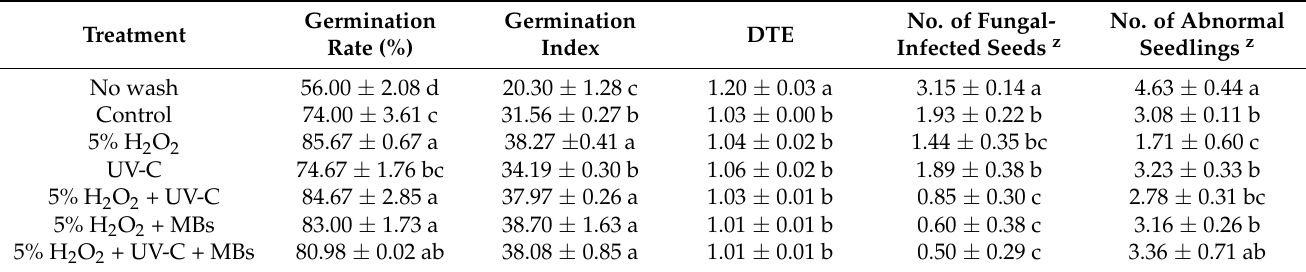
Table 2. Effects of seed decontamination treatments on percentage germination, germination index, days to emergence (DTE), the number of fungal-infected seeds, and abnormal roselle seedlings.